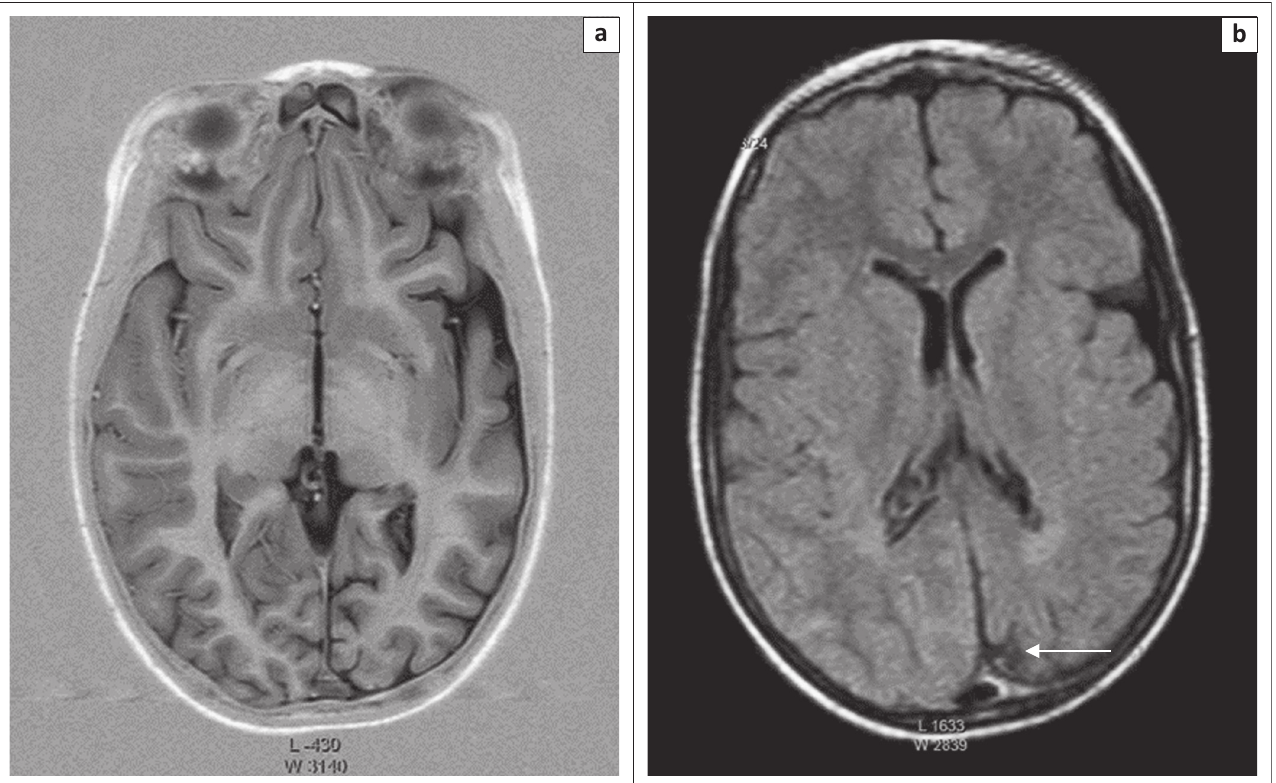
FIGURE 3: Axial T1 inversion recovery (a) and axial T2 FLAIR (b) images demonstrating atrophy of the left cerebral hemisphere and low signal in the left occipital lobe (arrow).